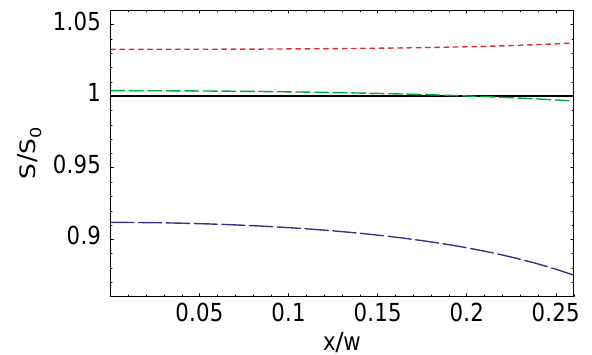
FIG. 9. (Color) Relative magnitude of beam-size corrections in a square chamber with s x (cid:2) w (cid:1) 0.1 , s y (cid:2) h (cid:1) 0.05 for three ver- tical beam offsets y (cid:2) h (cid:1) 0, 1 (cid:2) 8, 1 (cid:2) 4 (short-dashed line, dashed line, long-dashed line, respectively). Here “1” corresponds to a pencil beam case, i.e., to one of the three curves in Fig. 6 for the corresponding beam vertical offset.